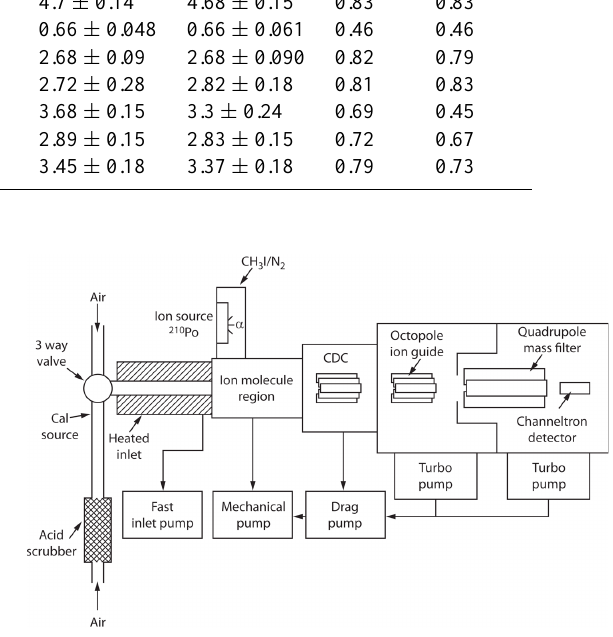
Fig. 1. Schematic of chemical ionisation mass spectrometer (CIMS) used in this study. Arrows indicate direction of gas flow. Dimen- sions are not to